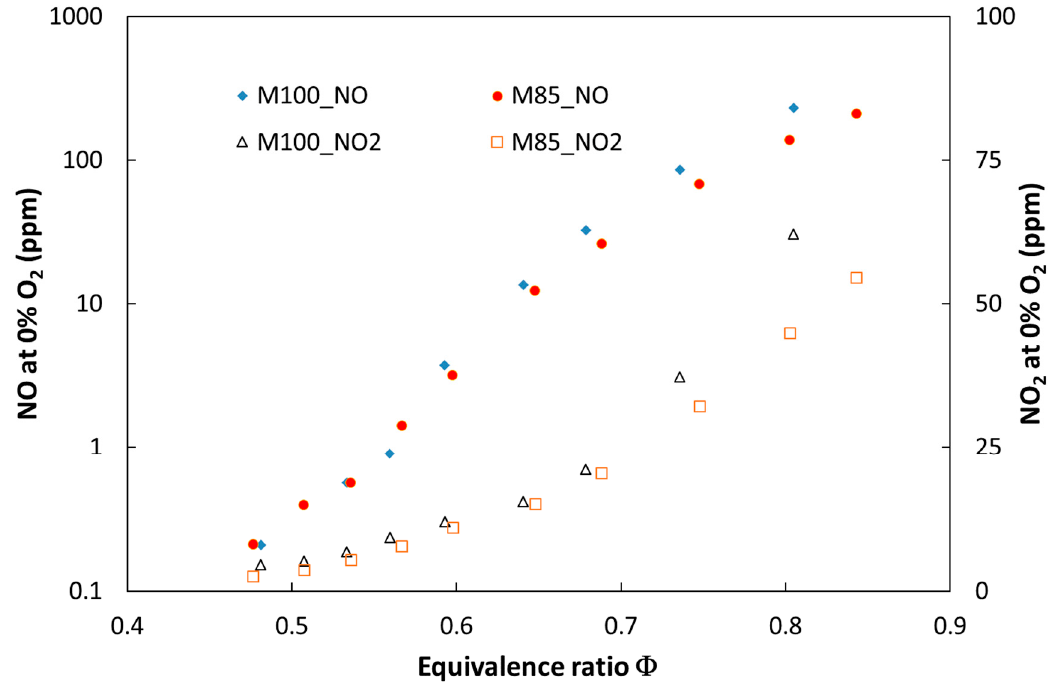
Figure 6. Experimental NO and NO 2 emissions for the tested fuels at elevated combustion pressure (P = 0.25 MPa) versus equivalence ratio.